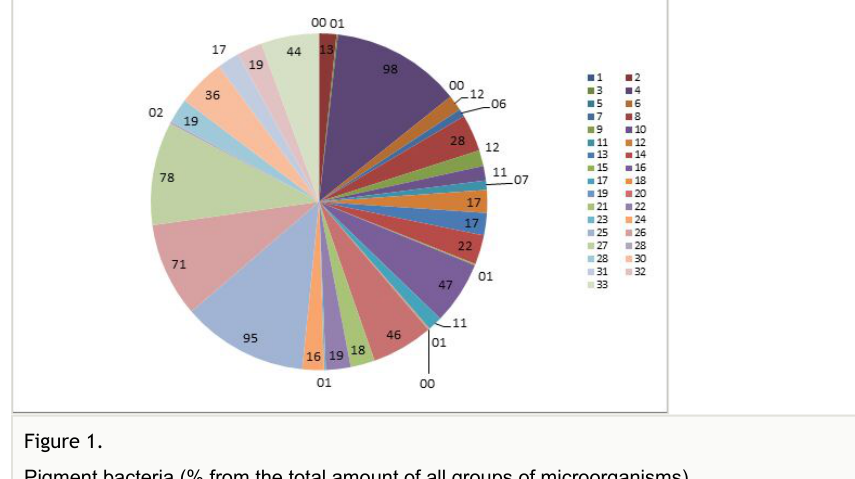
Figure 1. Pigment bacteria (% from the total amount of all groups of